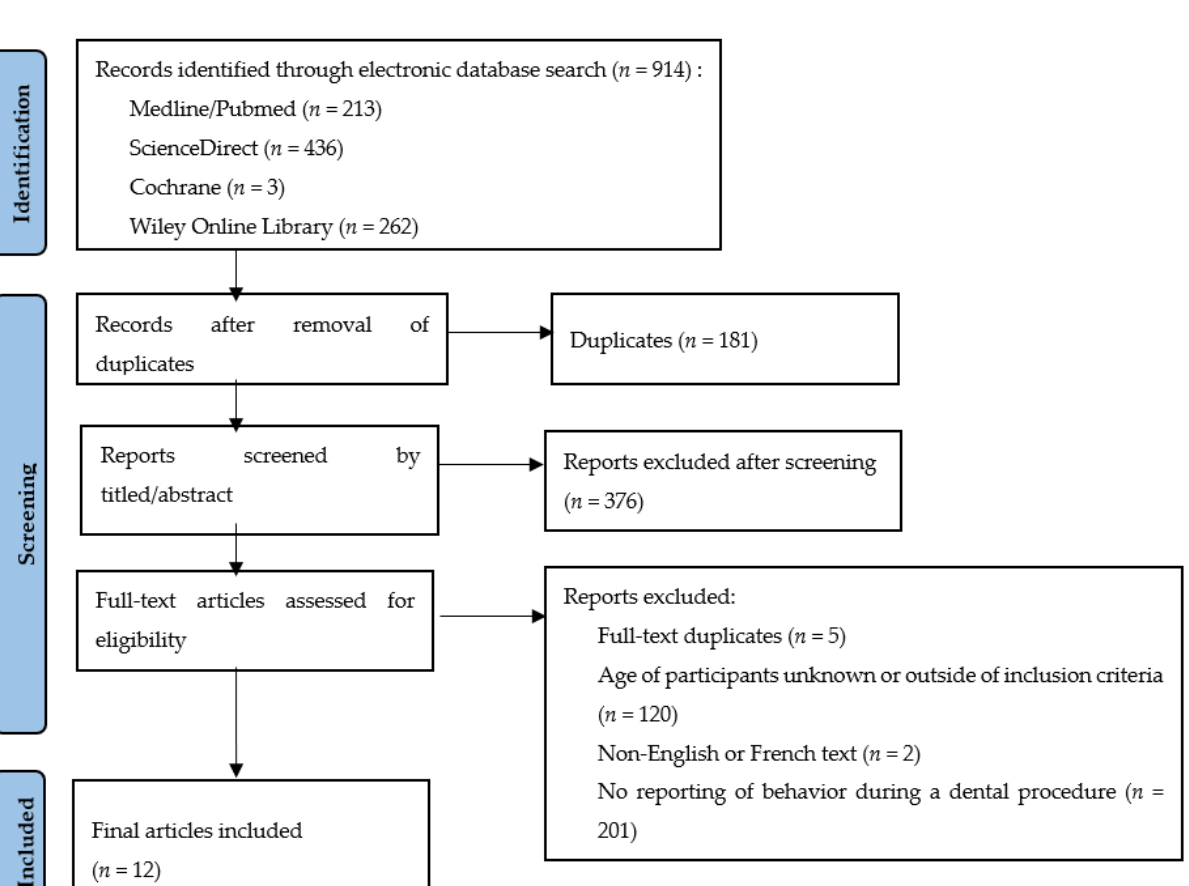
Table 2. Summary of the articles included in the literature review.